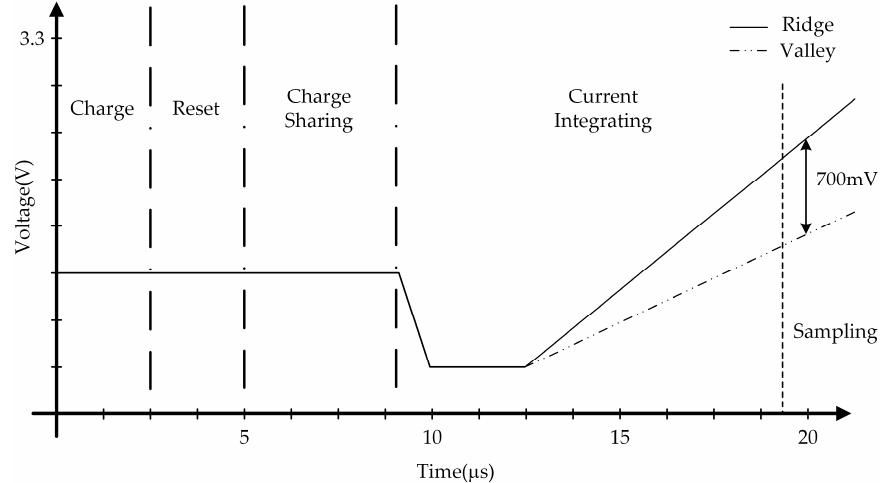
Figure 10. Simulation result of the AFE stage.